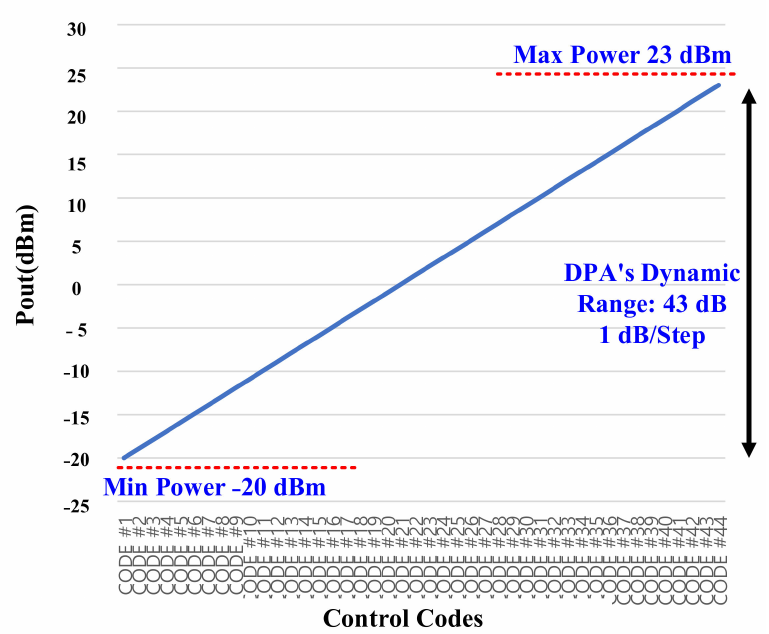
Figure 16. The measured gain steps and dynamic range for the high band (the results are standardized for the application using the 0.5 dB fine-gain adjustability and reducing the maximum power from 27 dBm to 23